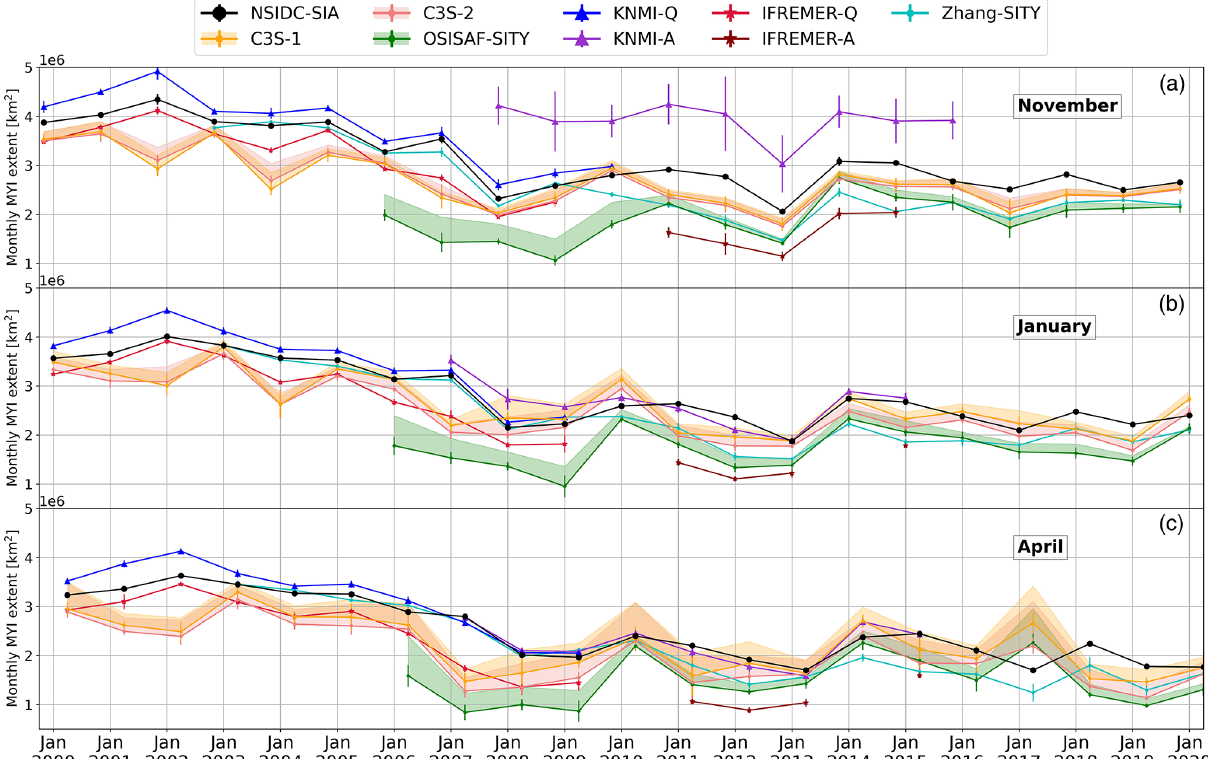
Figure 5. Monthly MYI extent of SITY products and NSIDC-SIA in November (a) , January (b) and April (c) from November 1999 to April 2020. The shaded area represents the ambiguous extent value for C3S-1, C3S-2 and OSISAF-SITY. The error bar represents the range between maximum and minimum MYI extent in the